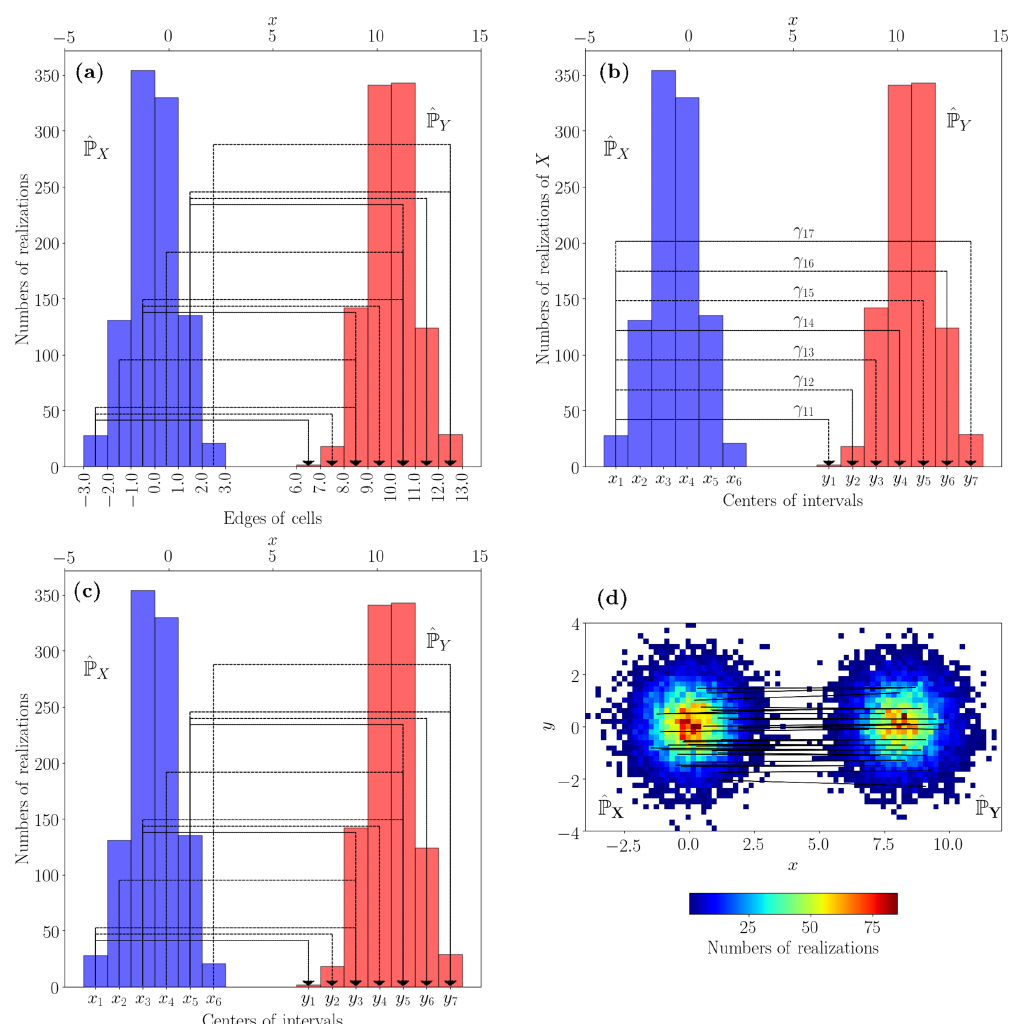
Figure 1. Histogram of two Gaussian laws X and Y in blue and red. (a) The x axis indicates the edges of each bar. The black arrows indicate how the quantile mapping matches an element of X with its correction. (b) The x axis gives the center of each bar. The black arrows indicate the possibilities for how the probability of obtaining the value x 1 for X can be distributed among the possible values y j of Y . The γ 1 j correspond to the number of realizations moved. These arrows can be generalized to each x i . (c) The x axis gives the center of each bar. The black arrows indicate the non-zero γ ij estimated by the OTC method. (d) Bivariate histogram of two Gaussian laws. The black arrows represent how the OTC method fits each x i with its correction. To facilitate readability, only 30 arrows are